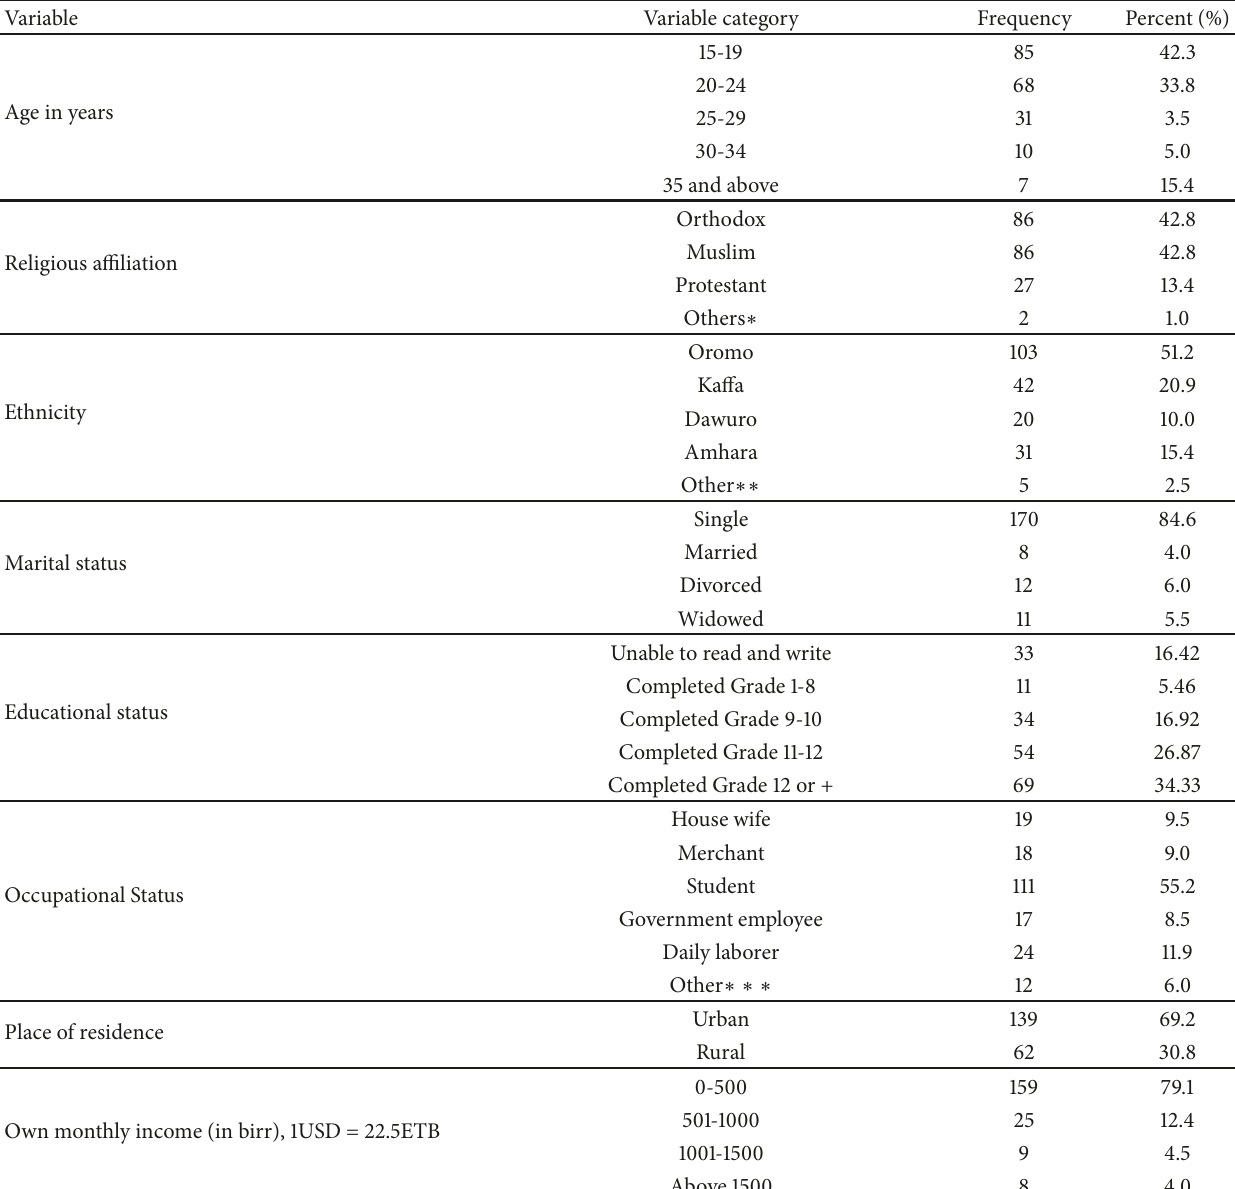
Table 1: Sociodemographic characteristicsof women who terminated their pregnancy using safe medical abortion at 2nd trimester in JUMC from November 1, 2016 to June 30,